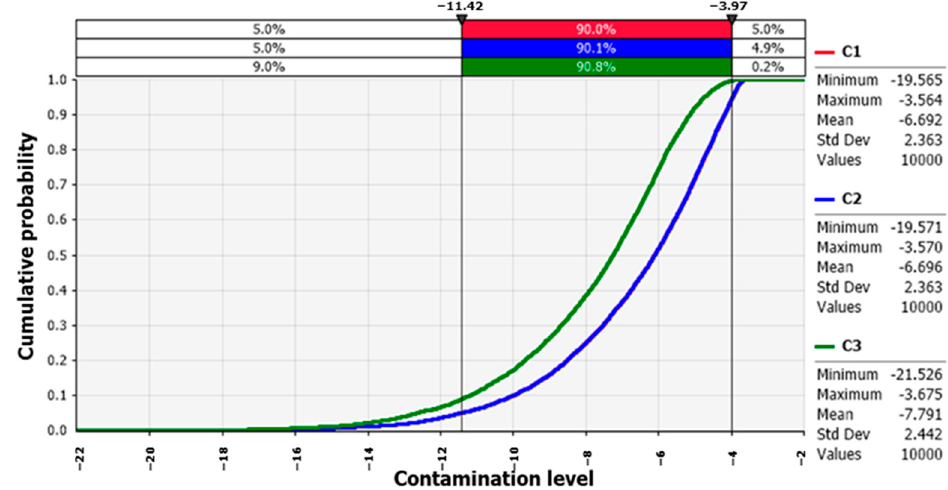
Figure 3. Changes in hepatitis A virus contamination level in the fermented clams according to transportation and storage.